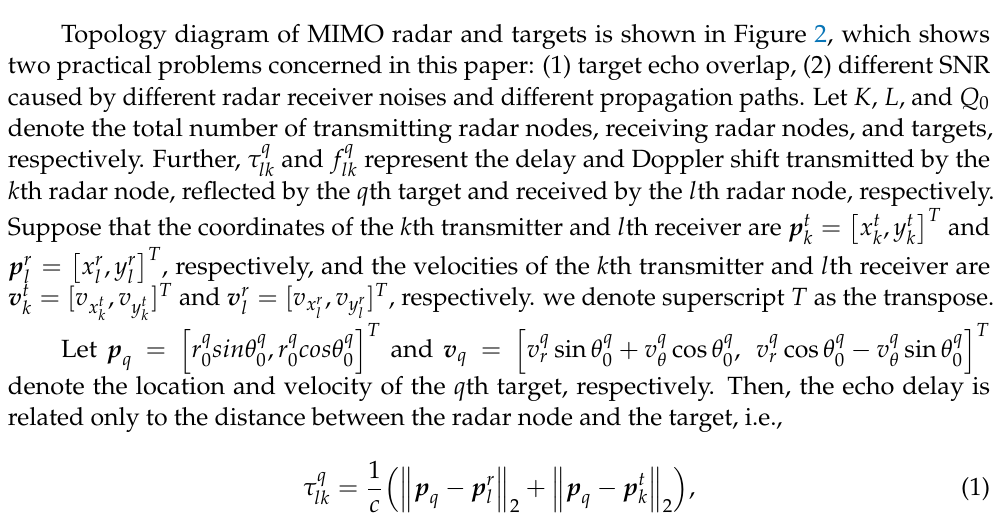
Figure 1. System diagram of multiple-input multiple-output (MIMO) radar with widely separated antennas on moving